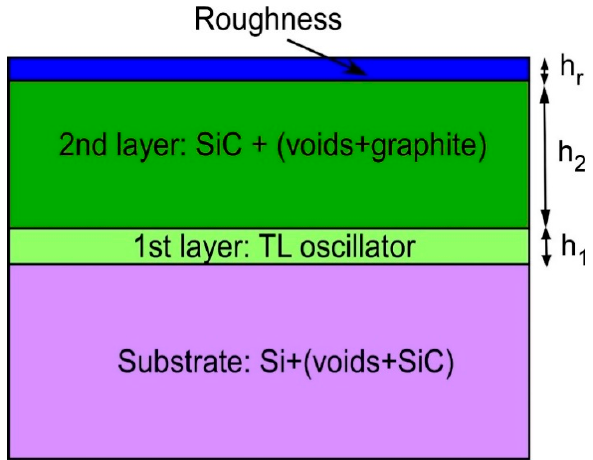
Figure 9. Universal two-layer ellipsometric model describing the optical properties of 3C- SiC(111)/Si(111) samples produced by the method of coordinated substitution of atoms. The optical constants of the intermediate layer separating 3C-SiC and Si are described by the Tauc-Lorentz (TL) oscillator.